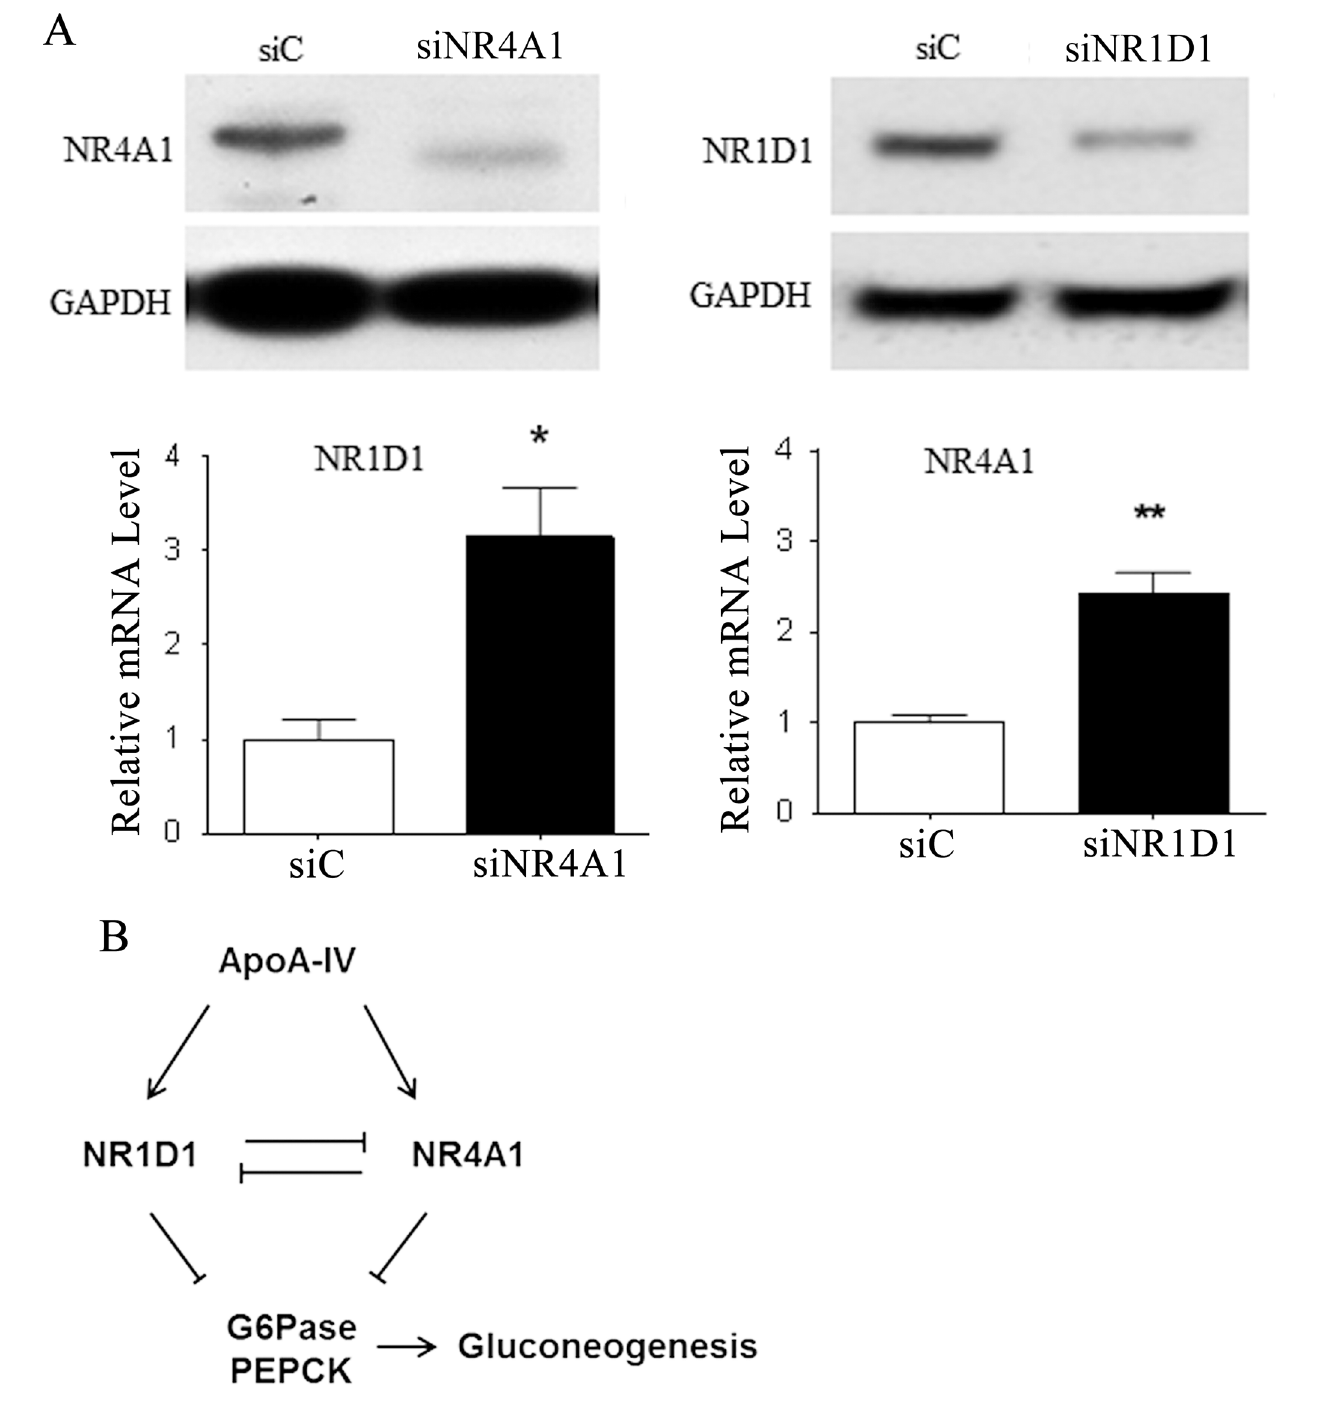
Fig 4. Mutual regulation of NR4A1 and NR1D1 expression in mouse hepatocytes. (A) Primary mouse hepatocytes were transiently transfected with siNR4A1, siNR1D1, or control siRNA (siC) for 48 h. (Lower panel) The levels of the NR1D1 and NR4A1 mRNAs were measured, relative to the cyclophilin control, using qRT-PCR. (Upper panel) The levels of the NR1D1 and NR4A1 proteins were measured, relative to the GAPDH control, by western blotting. Data are presented as the mean ± SE of at least three samples from three independent experiments ( * P < 0.05, and ** P < 0.01 vs. vehicle or siC control). (B) Diagram depicting the roles of ApoA-IV, NR4A1, and NR1D1 in the downregulation of hepatic glucose production. The ApoA-IV-induced expression of NR4A1 and NR1D1 represses the transcription of G6Pase and PEPCK in hepatocytes, which in turn reduces glucose output. The expression of NR4A1 and NR1D1 is also regulated by bidirectional feedback, in which each NR represses the expression of the other.